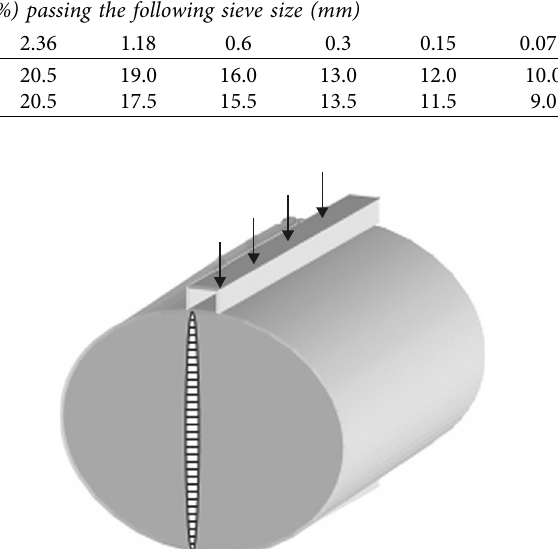
Figure 2: Comparison of advantages and disadvantages of labo- ratory fatigue test methods.